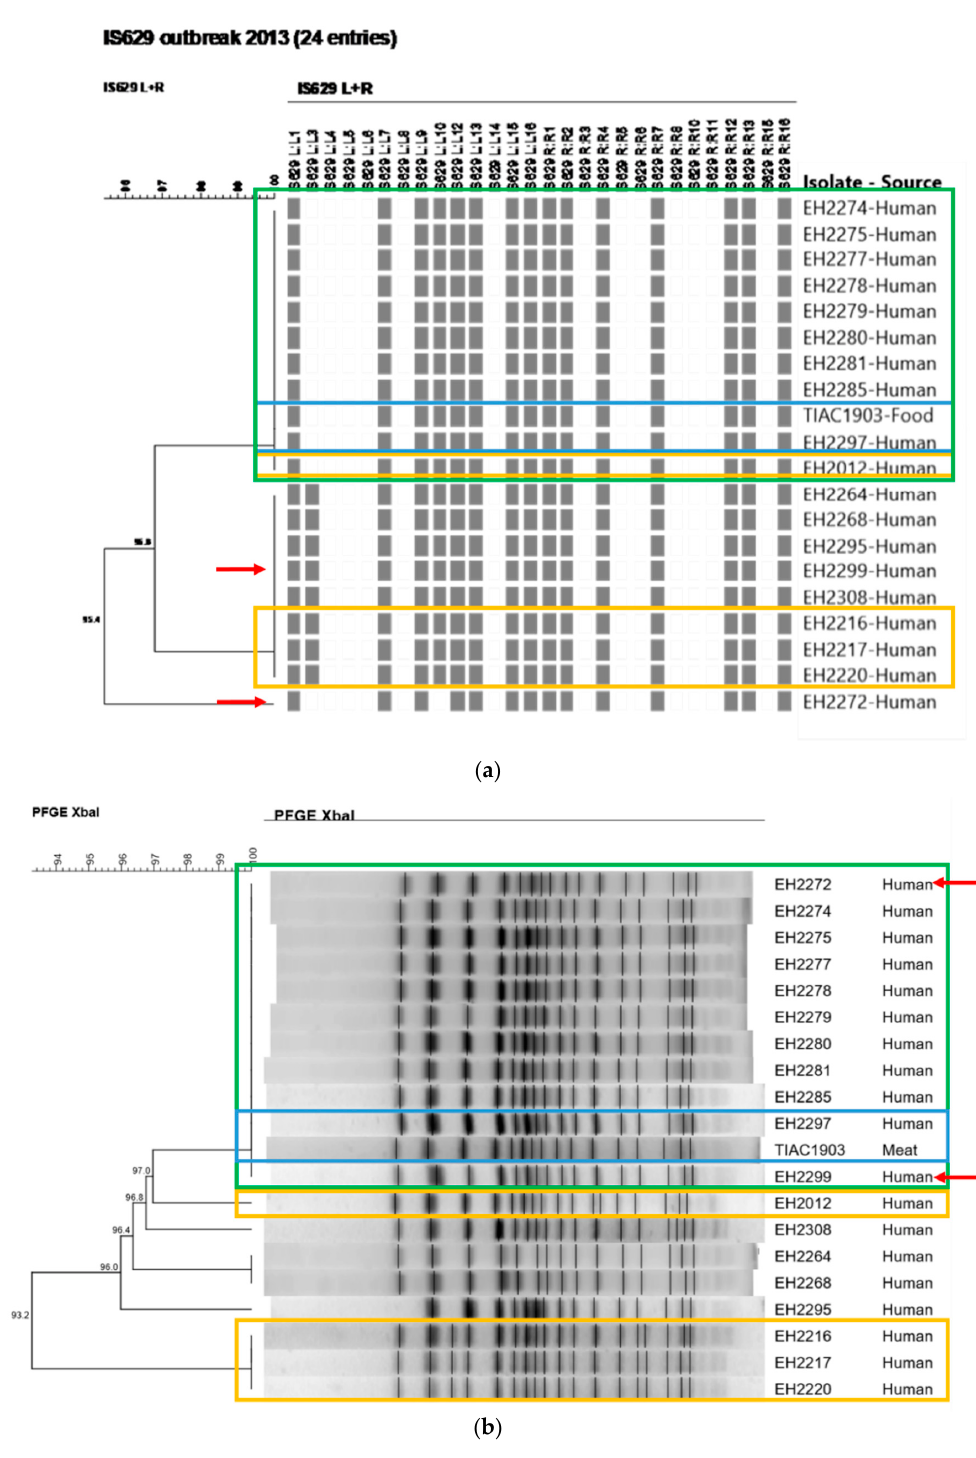
Figure 3. The IS629 fingerprints ( a ) and PFGE patterns ( b ) of all suspected isolates involved in the outbreak in Flanders (2013) are depicted. The scale bars represent the percentages of similarity between the isolates. All outbreak isolates clustering together (i.e., identical patterns) are outlined in a green box (identified as the outbreak cluster). The two isolates outlined in a blue box concern the human case for which the epidemiological link with the consumption of the contaminated food source (raw beef meat) was laboratory confirmed. Background isolates included in the initial outbreak investigation are outlined in a yellow box. Red arrows indicate the di ff erences in the outbreak clusters obtained with both conventional